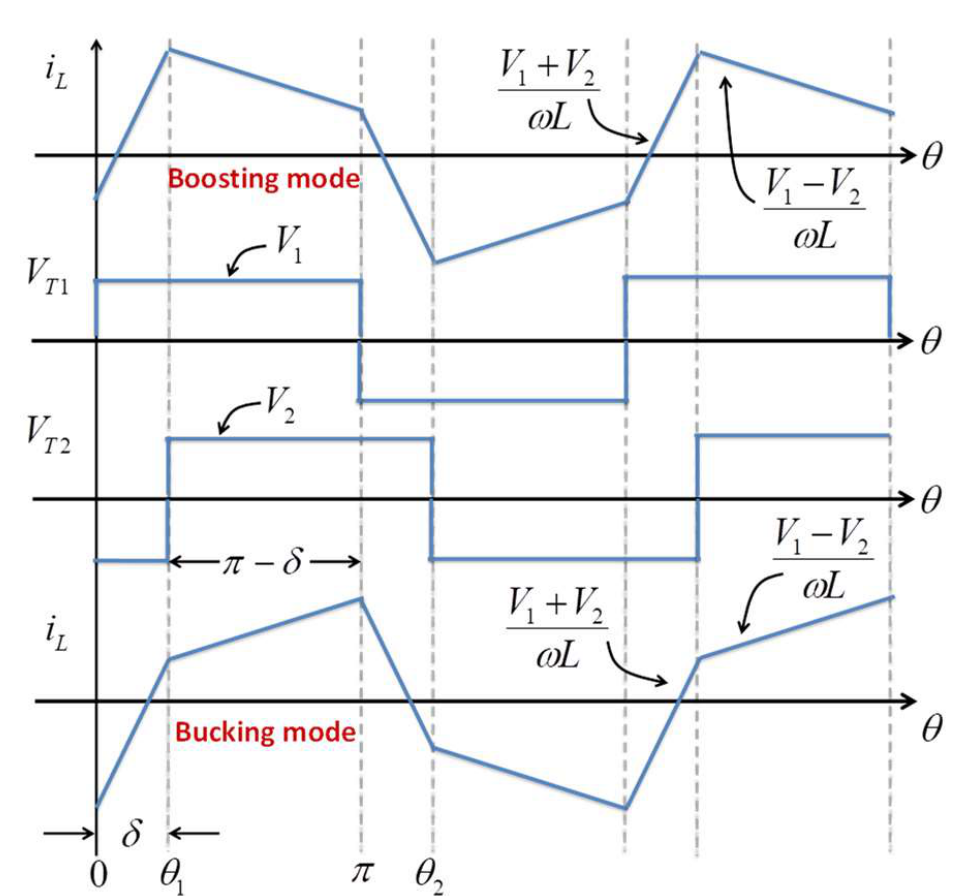
Figure 3. Traditional single-phase-shift (SPS) modulation main waveforms. Four different stages are employed for typical modulation. All the possible